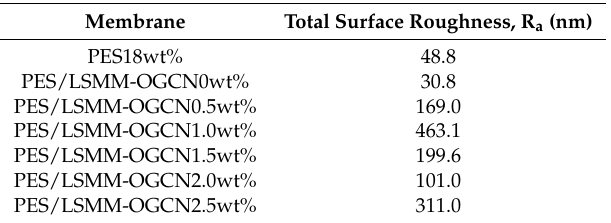
Table 2. PES/LSMM/OGCN membrane top surface roughness.